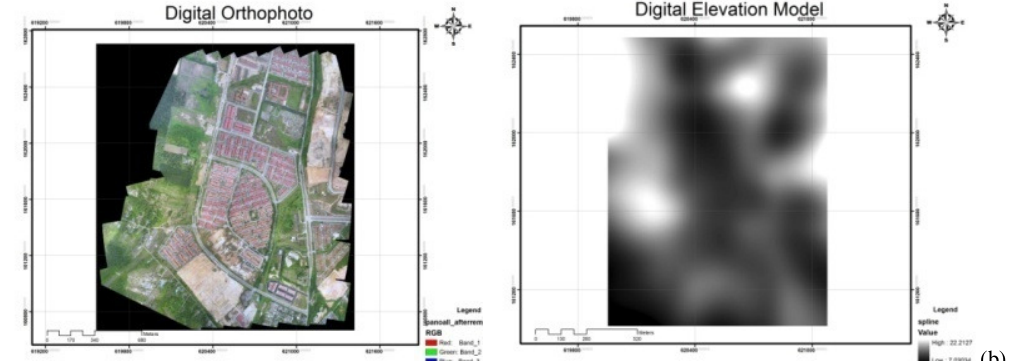
Figure 4. (a) Digital Orthophoto and Digital Elevation Model for Proposed Algorithm; (b) Digital Orthophoto and Digital